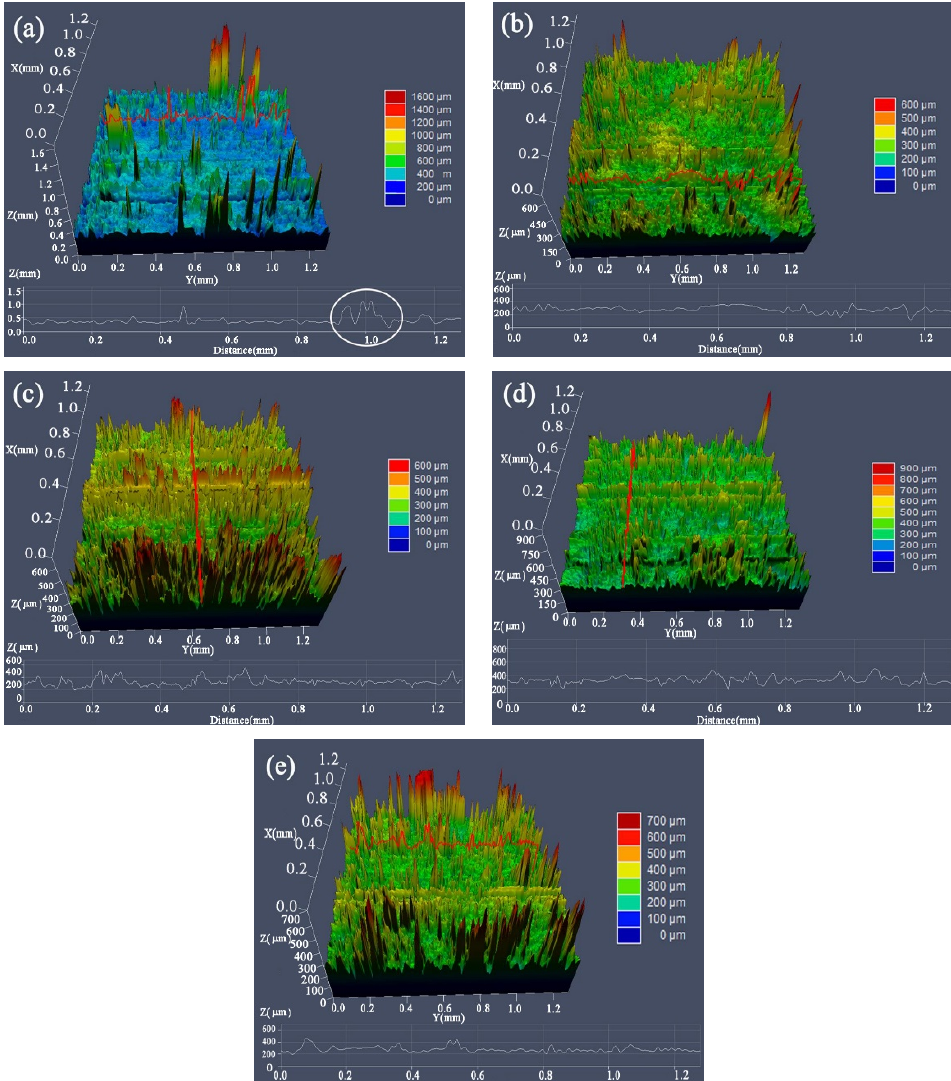
Figure 1. Thickness and roughness of MAO coatings.